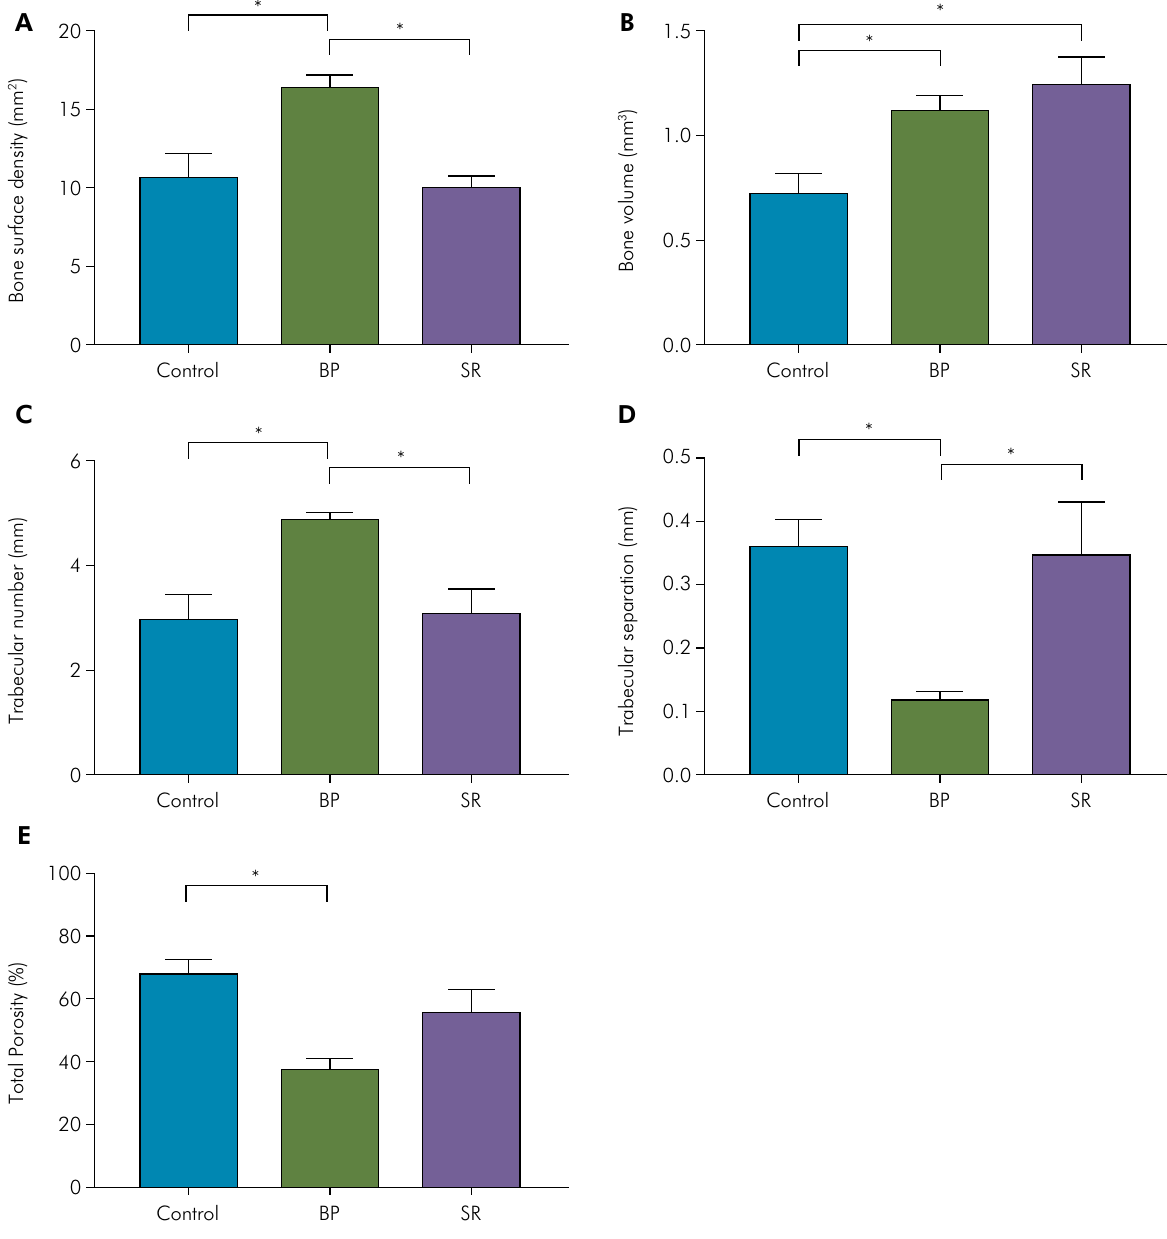
Figure 4. Microtomographical aspects of control, BP, and SR groups. a) Higher bone surface density in the BP group. Mean ± SEM *p<0.05 (ANOVA, followed by Tukey test). b) Higher bone volume in groups treated with anti-resorptives (BP and SR). Mean ± SEM *p<0.05 (ANOVA, followed by Tukey test). c) Expressive increase in the number of trabeculae in the BP group. Mean ± SEM *p<0.05 (ANOVA, followed by Tukey test). d) Decreased trabecular separation in the BP group. Mean ± SEM *p<0.05 (Kruskal–Wallis, followed by Dunn’s test). e) High bone porosity percentage in the control group. Mean ± SEM *p<0.05 (Kruskal–Wallis, followed by Dunn’s